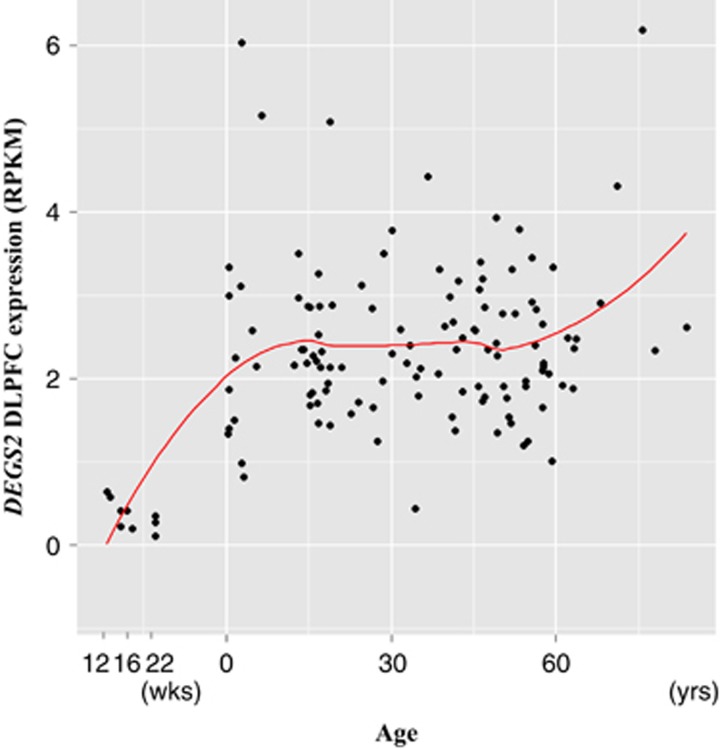
Developmental expression pattern of a DEGS2 transcript in postmortem brains. The expression of DEGS2 in the DLPFC across the lifespan was displayed from gestational week 12 through 22 and from birth through old age. Gene expression in each individual subject is shown as a black dot. A curved line represented a LOESS fit across the lifespan. DLPFC, dorsolateral prefrontal cortex; RPKM, Reads Per Kilobase per Million mapped reads.